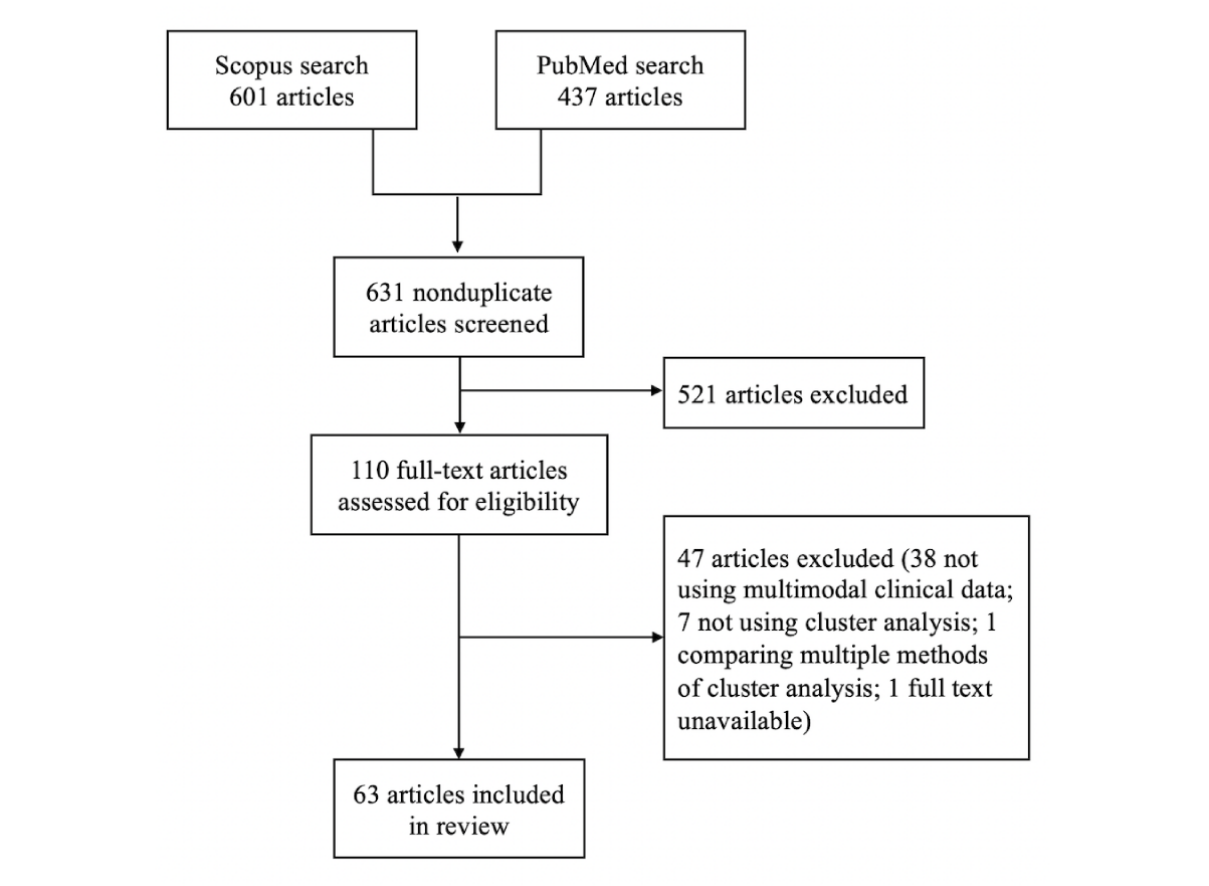
Figure 2. Flow of studies into